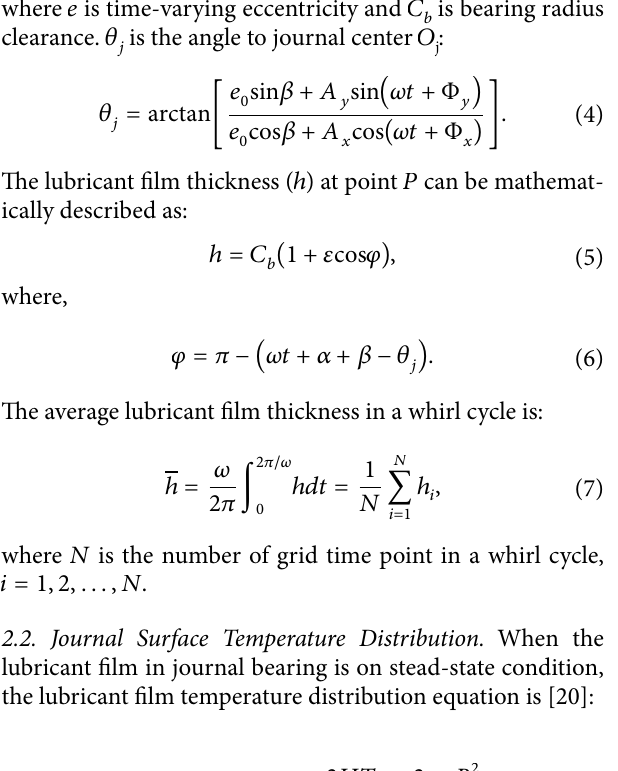
Figure 1: Schematic diagram of synchronous whirl elliptic